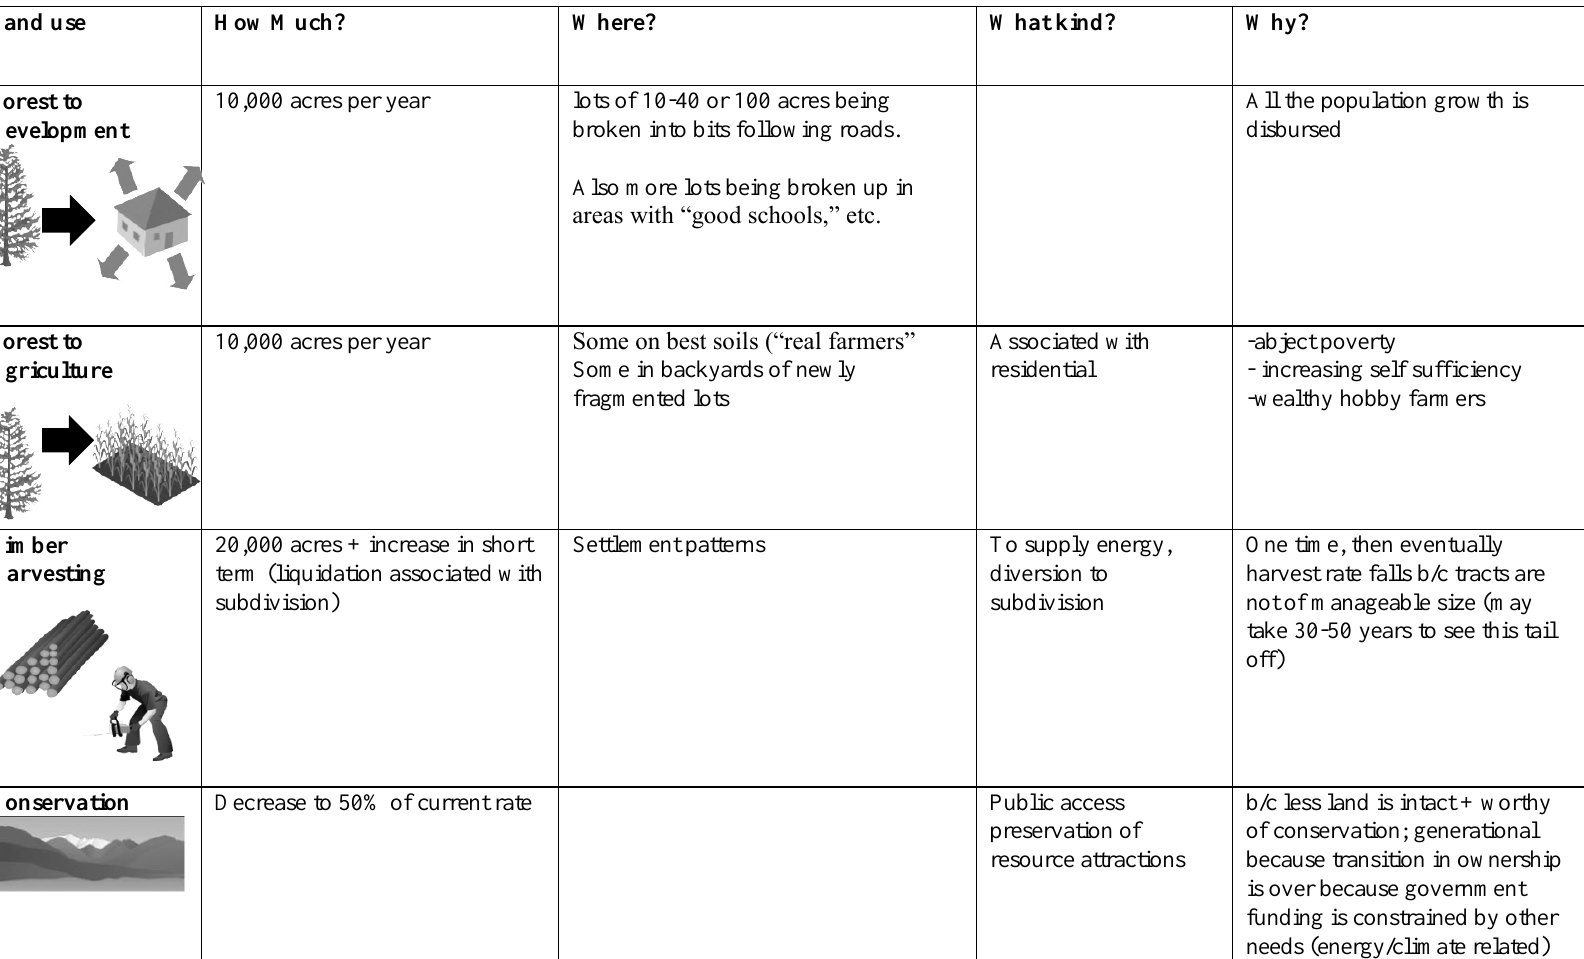
Table A2.24. Scenario 4: Little House on the